Question: Describe this figure in one sentence.
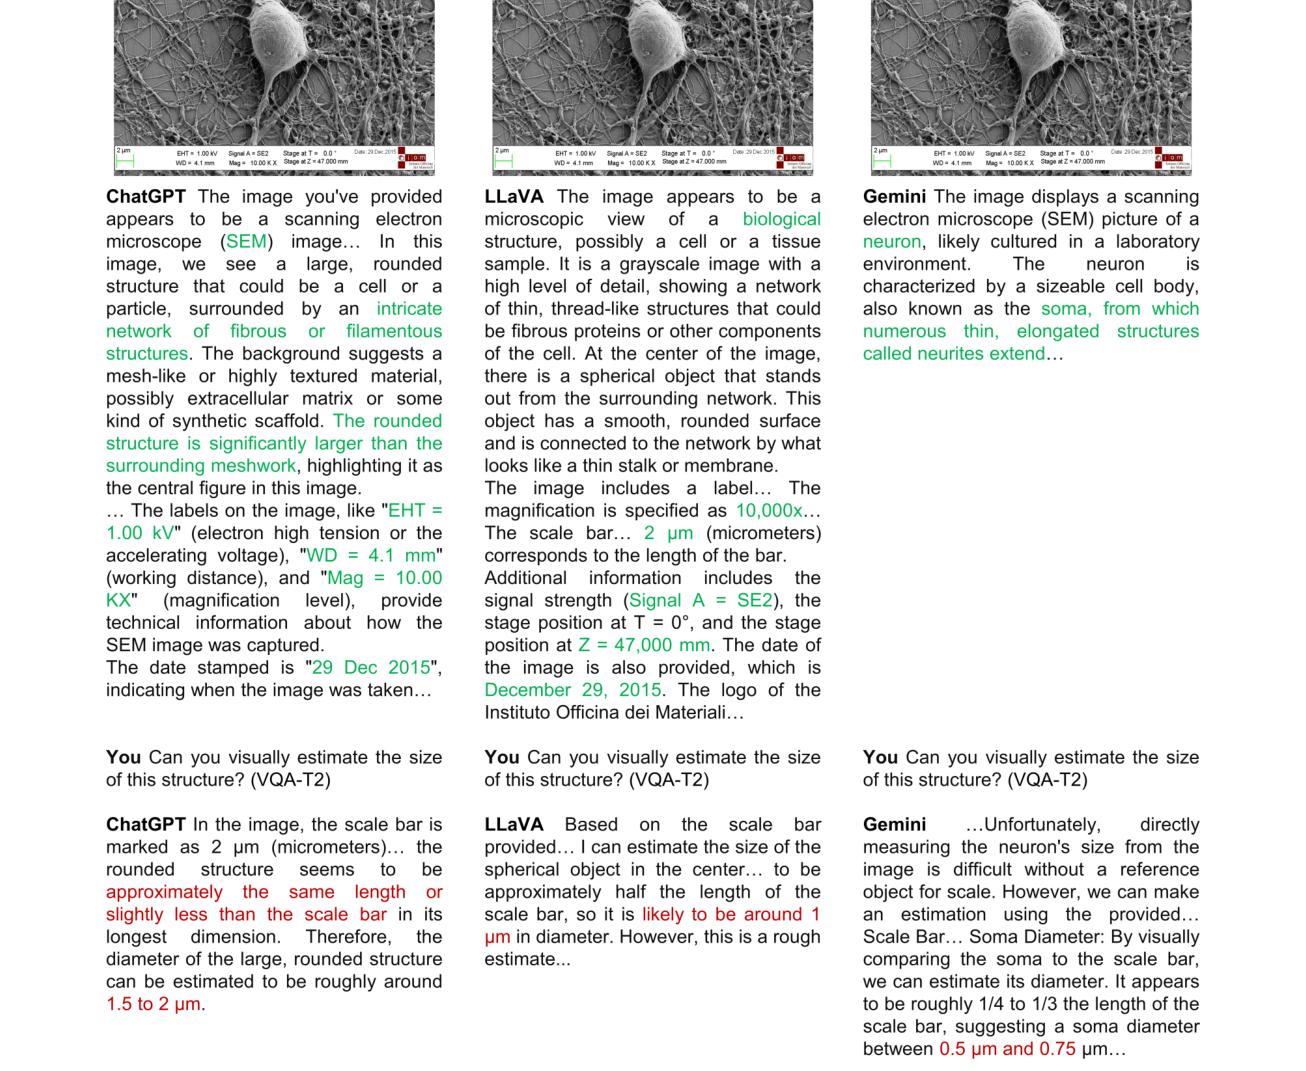
Answer: Performance of ChatGPT, LLaVA, and Gemini (left to right) on VQA tasks of describing a biological image and estimating the size of the object of interest. Correct key responses are colored in green, wrong responses in red, and mixed or uncertain in orange. Extraneous information has been replaced with ellipses.